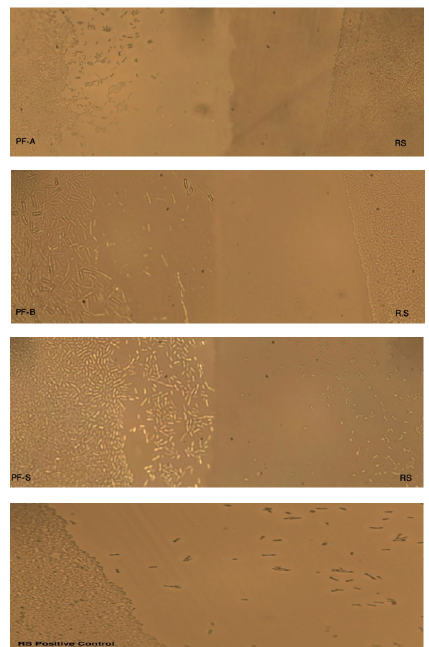
Figure 2. Digital images (400X) of microscopic analysis in bright field representing the interactions of Pseudomonas fluorescens species against Ralstonia spp. PFA, PFB and PFS represent P. fluorescens (PF) species (see Table 1), and RS represents Ralstonia spp . Both PF and RS were streaked near to each other to see the interaction between the two